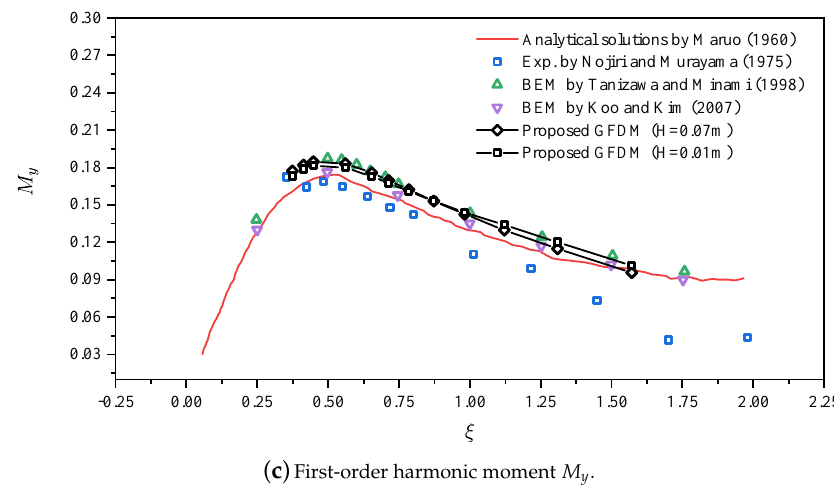
Figure 7. Numerical comparisons of the first-order harmonic components of the hydrodynamic loads acting on the body surface. F x is normalized by ρ gLd ( H /2 ) , F z by ρ gLB ( H /2 ) , and M y by ρ gLBd ( H /2 ) with L = 1m, B = 0.5m, d = 0.25m and H = 0.07m (or H =